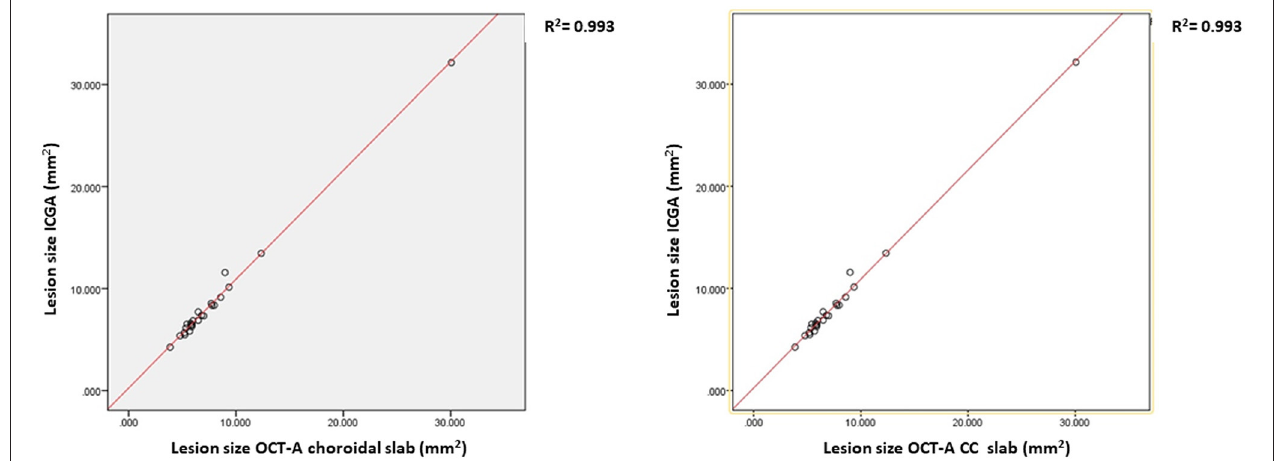
FIGURE 2 | The correlation and the regression lines between the lesion size on Indocyanine angiography (ICGA) and OCTA choriocapillaries (CC) slabs (left) and between the ICGA and the OCTA choroidal slabs (right)